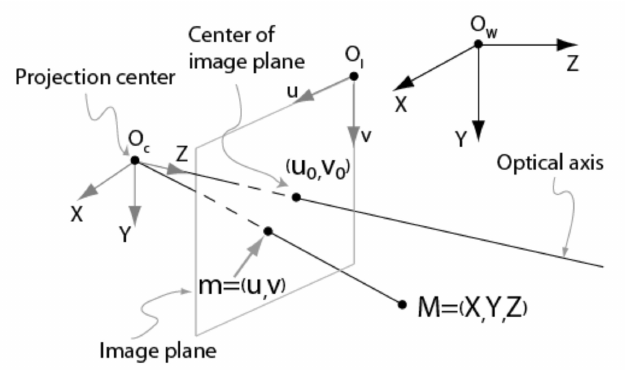
Figure 3. Geometric image formation process. A 3D point M in the world reference frame O W is projected on the image plane as point m with coordinates ( u , v ) in the image reference frame O i . The center of the image plane (i.e., the location of the intersection between the optical axis and the image plane) is located at ( u 0 , v 0 ) in the reference frame of the image O i . The center of projection of the pinhole is at the origin O C of the reference frame attached to the camera. Table 3. Definition of parameters of the geometric model of the cameras. Parameter